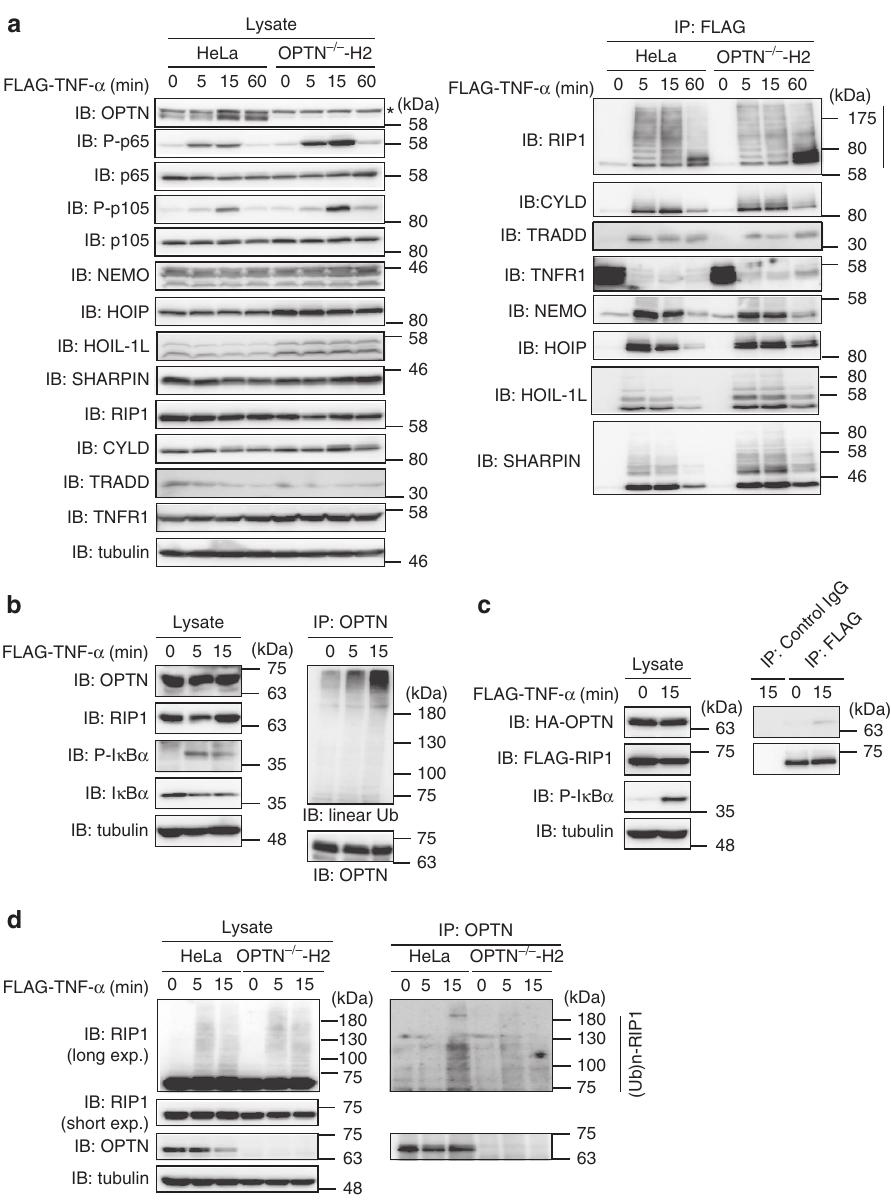
Figure 4 | OPTN regulates TNFR signalling complex I. ( a ) Parental and OPTN- KO HeLa cells were stimulated with FLAG-TNF- a for the indicated times and then TNFR complex I was immunoprecipitated using an anti-FLAG antibody, followed by immunoblotting using the indicated antibodies. ( b ) Association of endogenous OPTN with free and/or conjugated linear ubiquitin chain on TNF- a stimulation. HEK293T cells were treated with FLAG-TNF- a and anti-OPTN immunoprecipitates were blotted with an anti-linear ubiquitin antibody. ( c , d ) Association of OPTN with RIP1 on TNF- a stimulation, examined at overexpressed ( c ) and endogenous ( d )